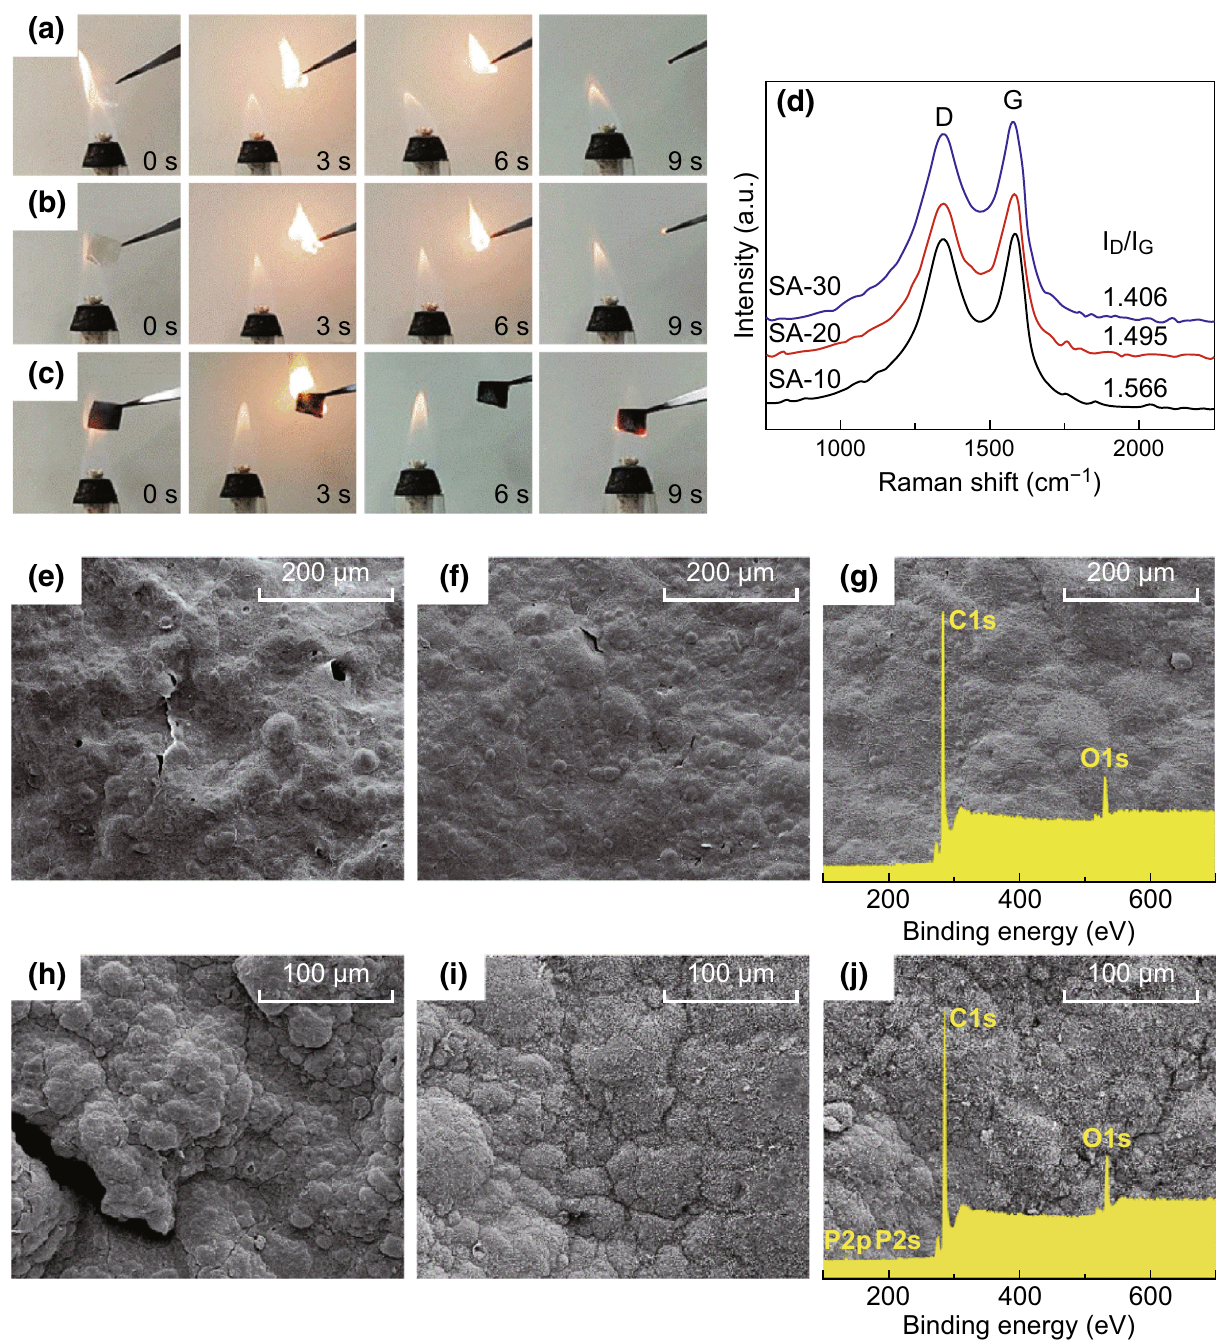
Fig. 8 Snapshots of flame treatment of a PVA film, b PVA/FGO composite film, and c LBL-assembled FGO-coated PVA film with 10 bilayers with respect to time in 9 s. d Raman spectra of PVA coated with different self-assembled (FGO/PEI) bilayers after flame treatment. SEM images of external surfaces of FGO-based coating residue with e 10, f 20, and g 30 bilayers and internal surfaces of FGO-based coating residue with h 10, i 20, and j 30 bilayers. The insert shows XPS spectra of external and internal surfaces of FGO-based coating